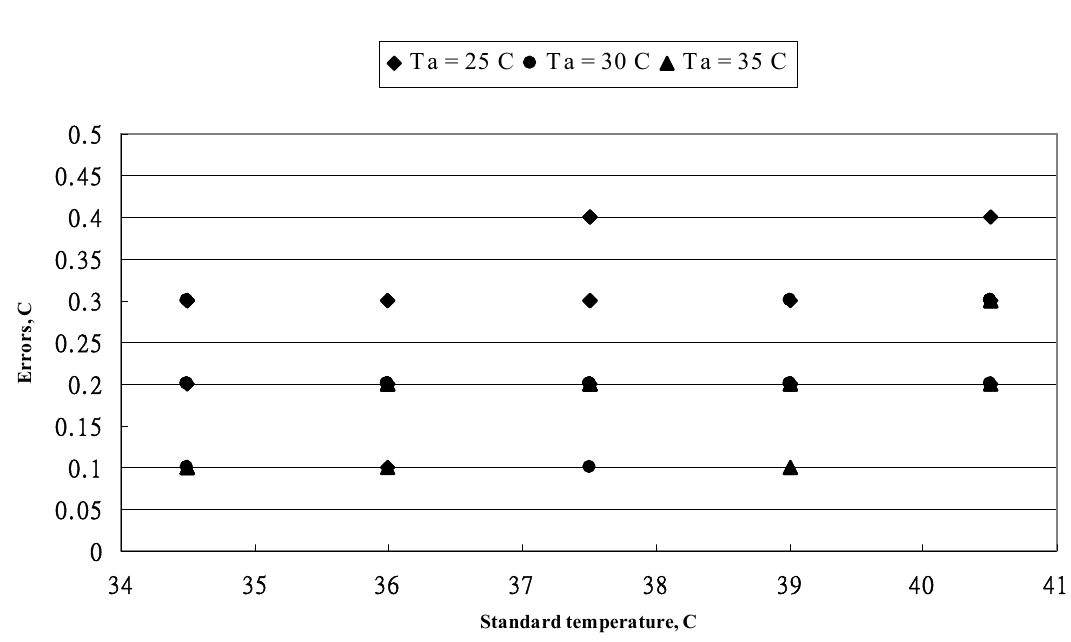
Figure 5. The error distribution of BRAUN IRT-3020 thermometer at three ambient